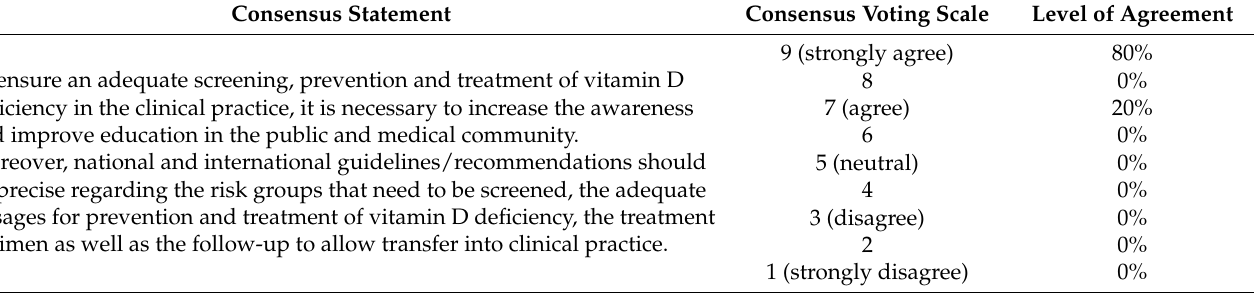
Table 3. Statement regarding the current situation of vitamin D deficiency diagnosis, prevention, and